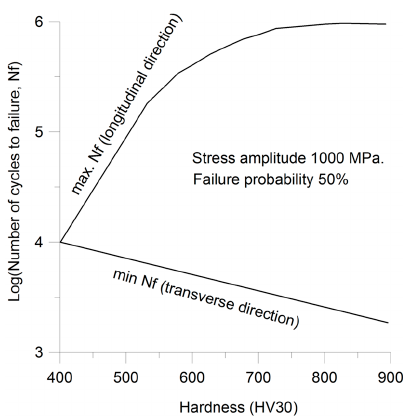
Figure 2. Material anisotropy effects in fatigue-life for tool steels after ref. [7].